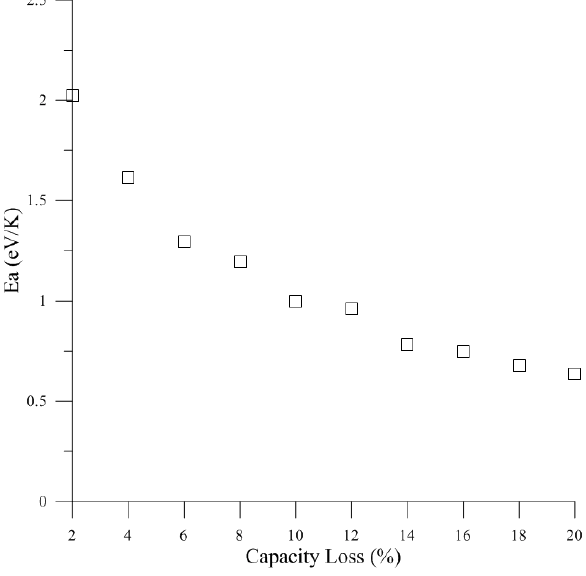
Figure 7. The activation energy vs. the capacity loss.